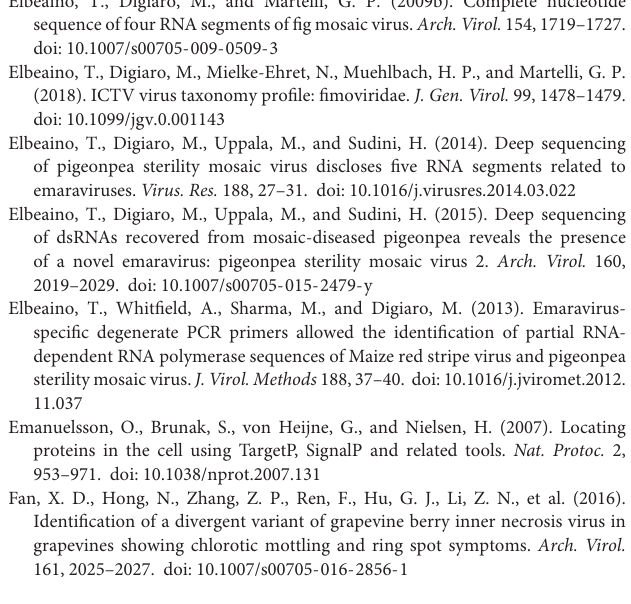
Supplementary Figure 1 | Conserved motifs A, B, C, D, and E in P1 of grapevine emaravirus A (GEVA) and other emaraviruses. Supplementary Figure 2 | Conserved motifs in P3 of grapevine emaravirus (GEVA) and other emaraviruses. Supplementary Figure 3 | Size distribution of 18- to 30-nt sRNAs derived from grapevine emaravirus A (GEVA) positive- and anti-genomic RNA strands. Supplementary Figure 4 | Relative frequency of 5 (cid:48) -terminal nucleotides of 18–30 nt grapevine emaravirus A (GEVA)